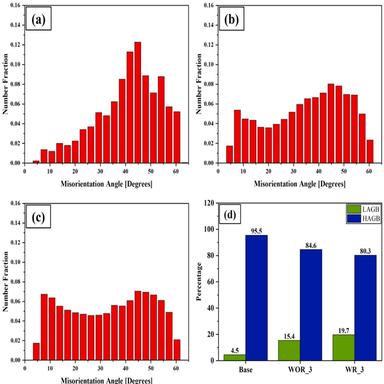
Misorientations histograms measured in the (a) Base, (b) WOR_3, (c) WR_3 condition and (d) comparison of HAGB and LAGB for all material conditions.